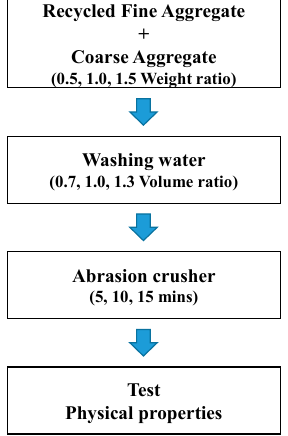
Figure 2. Experiment process of the manufacture of high-quality of recycled fine aggregate.